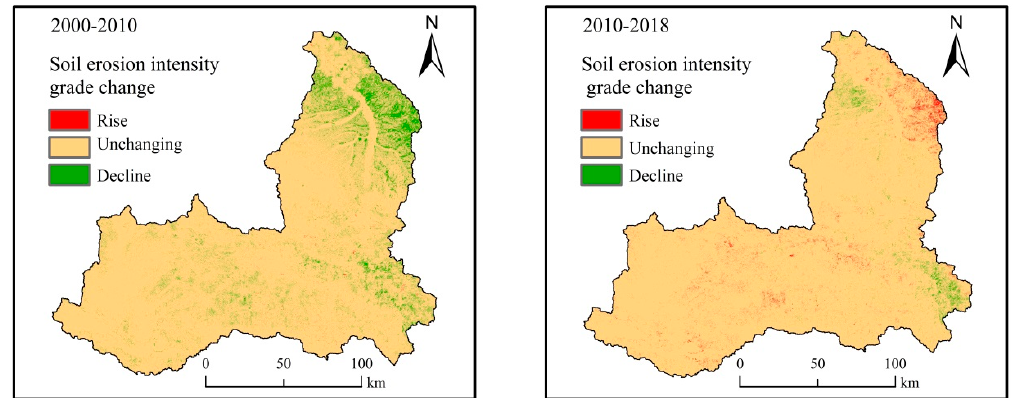
Figure 7. Spatial distribution of soil erosion intensity grades change in the Taohe River Basin.